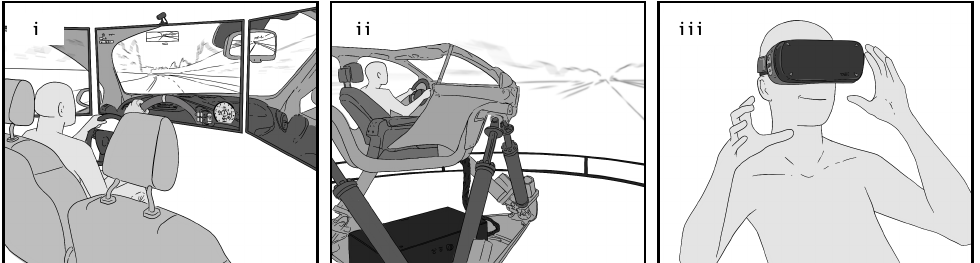
Figure 4. Typical simulator hardware used in the automotive domain: ( i ) compilation of three displays and an interior mock-up, ( ii ) vehicle (mock-up) in a CAVE-like environment—here, with hexapod-based motion platform, ( iii ) head-mounted VR display. Illustrations provided by our colleague Matthias